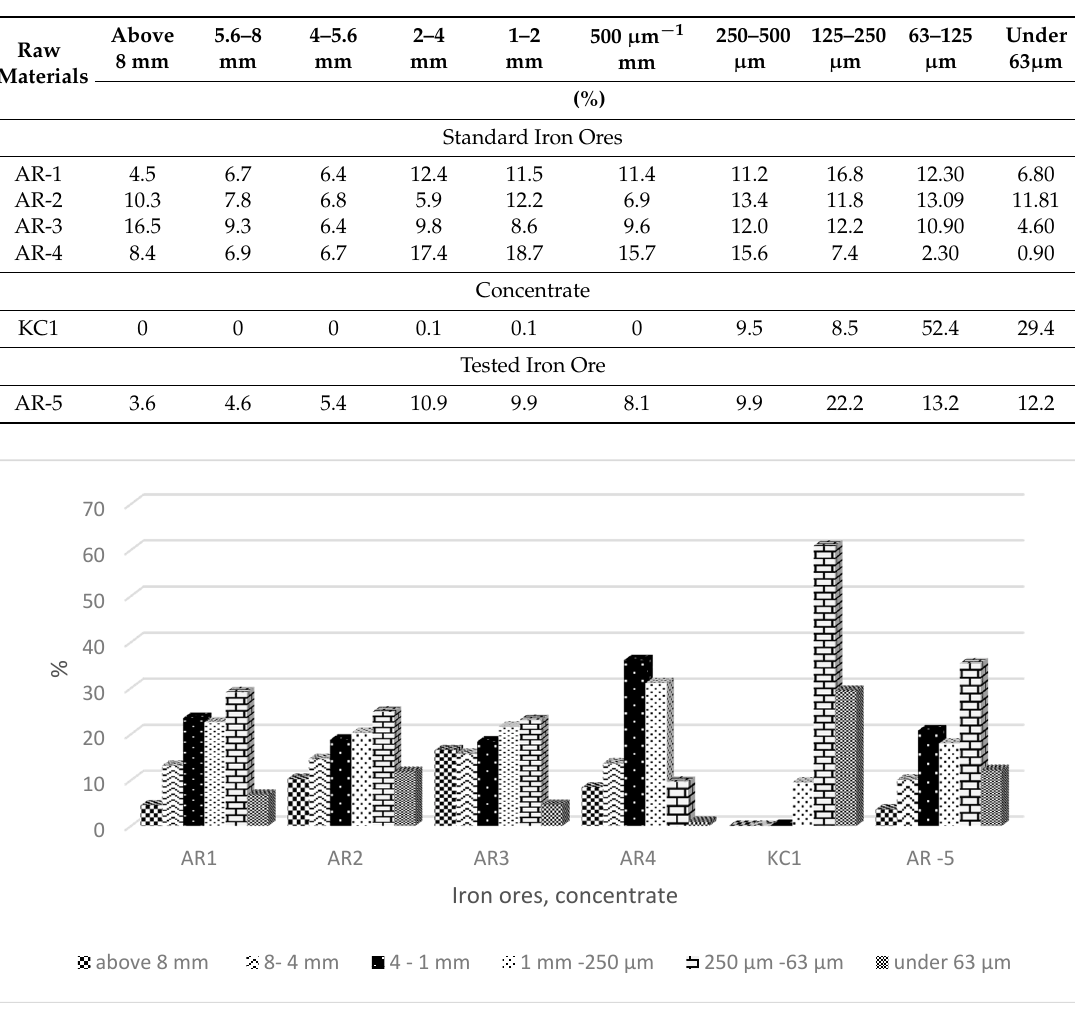
Figure 1. Granulometric composition of used raw materials.